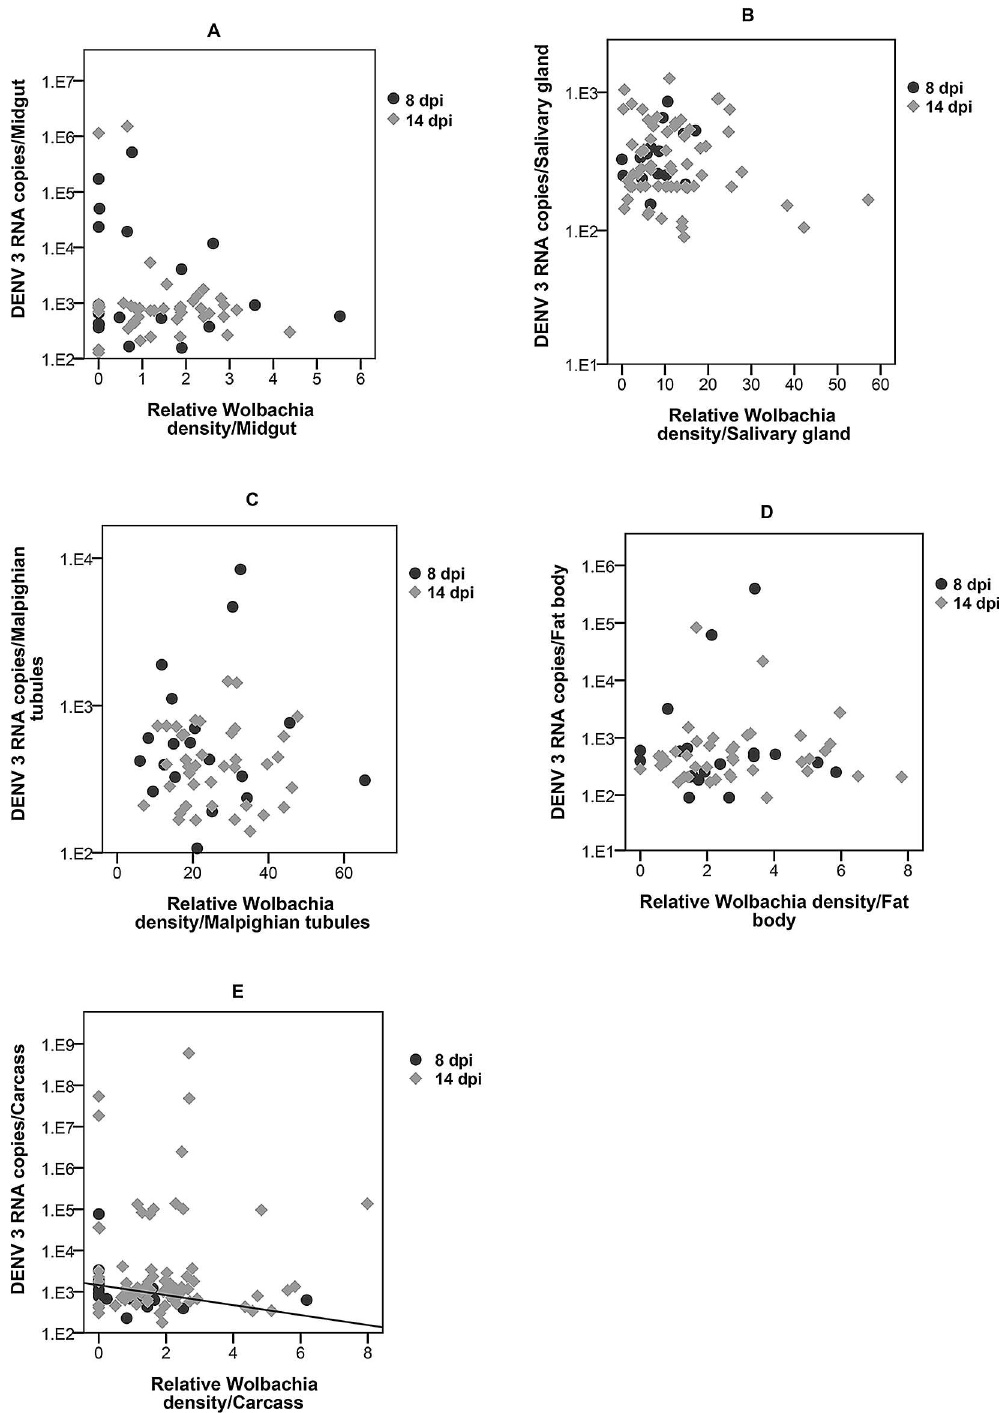
Fig 6. Correlation between Wolbachia density and DENV load in w Mel.F tissues. No correlationbetween Wolbachia density and DENV load in the midgut (A) , salivary glands (B) Malpighian tubules (C) , fat body (D) at 8 and 14 dpi. (E) DENV load decreased as Wolbachia density increased(LinearR 2 = 0.125) in the carcass at 8 dpi but not at